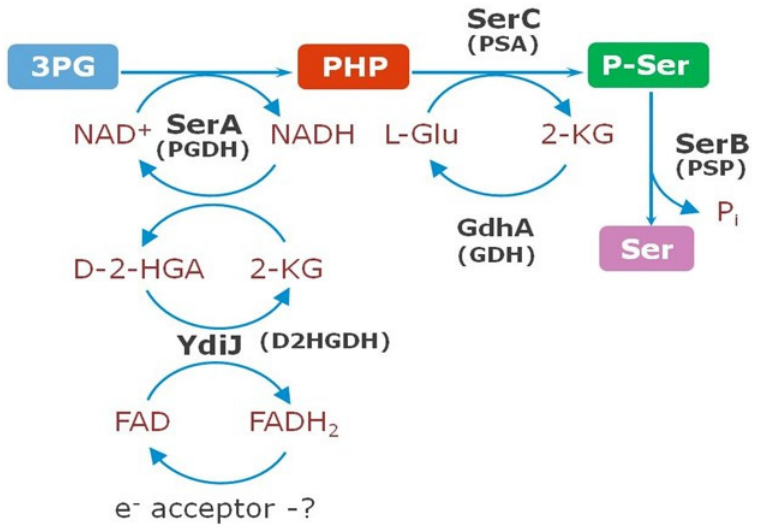
Figure 9. Schematic diagram of L-serine biosynthesis in P. ananatis and E. coli , associated with re- cycling of D-2-HGA by YdiJ (D2HGDH). GDH—glutamate dehydrogenase; P i —inorganic phos- phate.